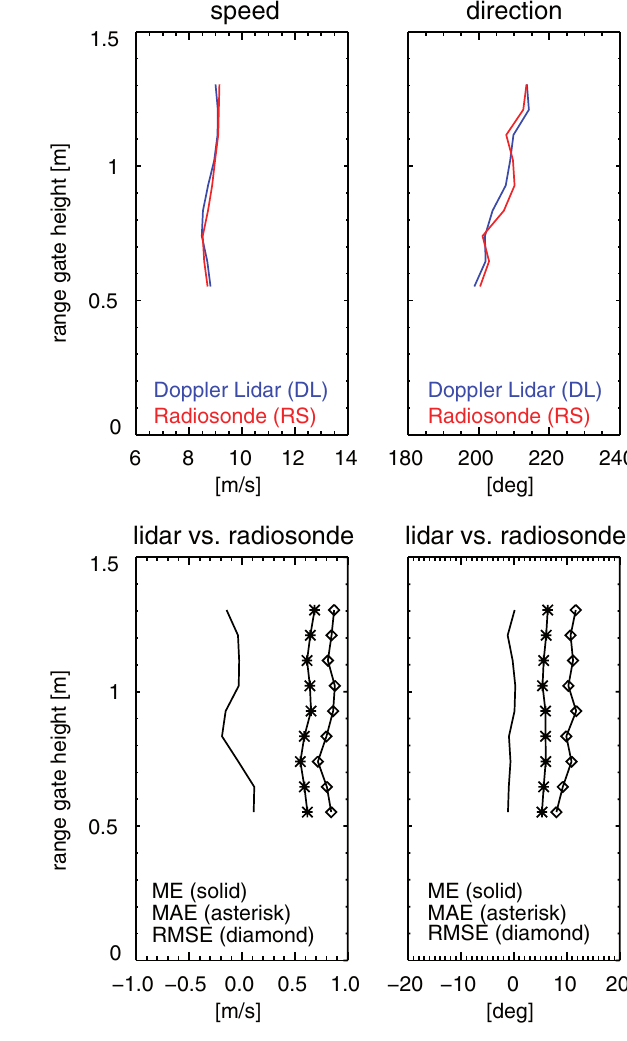
Figure 11. Same as in Fig. 10 but for the DLRS